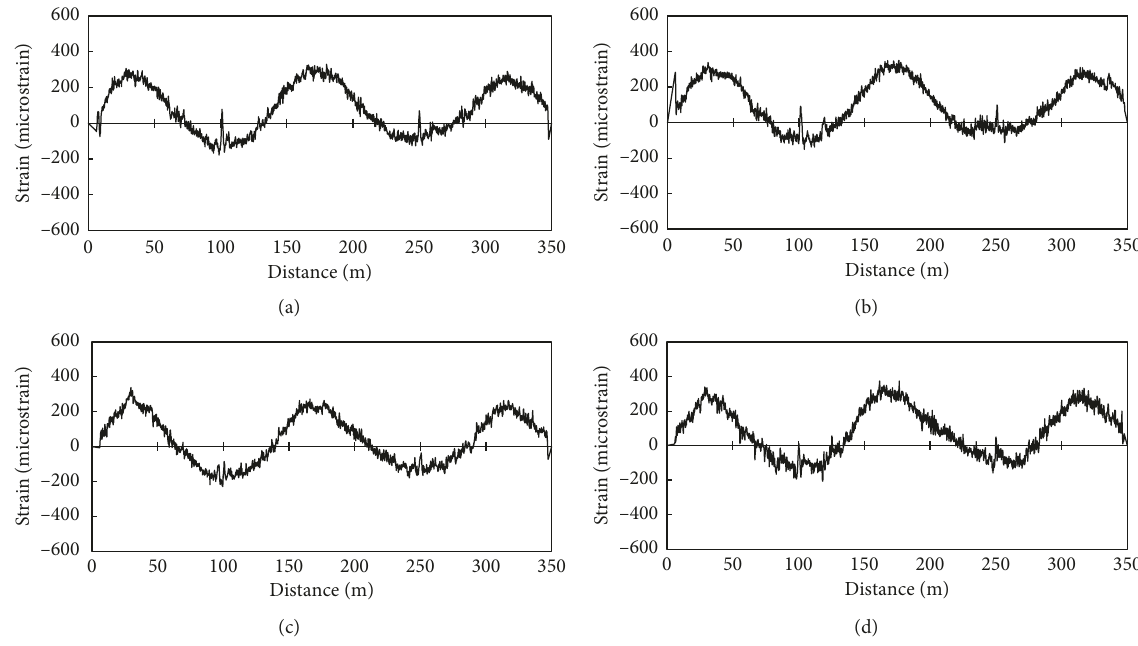
Figure 7: Strain diagrams of lines 1–4 after dismantling the scaffolding. (a) Line 1. (b) Line 2. (c) Line 3. (d) Line 4.